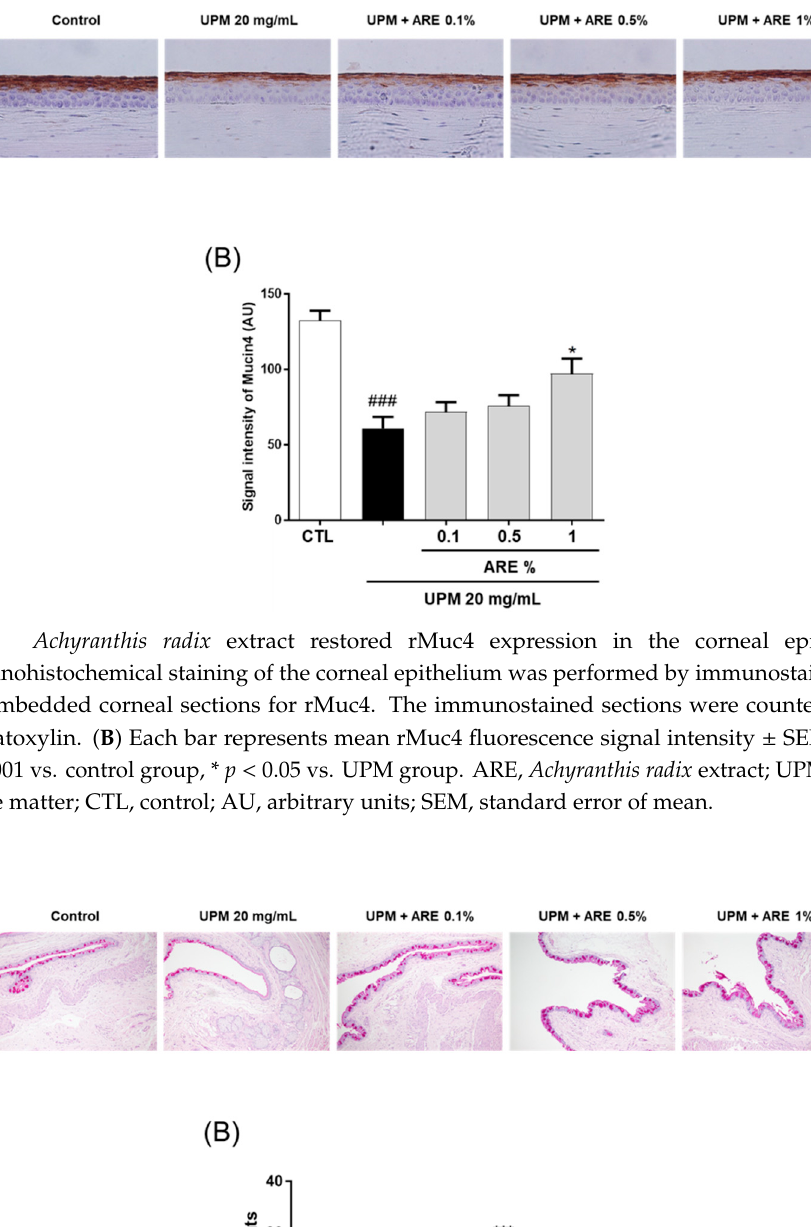
Figure 6. Achyranthis radix extract restored goblet cell population in the conjunctival epithelium. ( A ) Representative PAS-stained images of conjunctival sections. The violet colored cells are goblet cells. ( B ) Each bar represents the mean number of goblet cells ± SEM, n ≥ 3. ### p < 0.001 vs. control group, * p < 0.05, *** p < 0.001 vs. UPM group. ARE, Achyranthis radix extract; UPM, urban particulate matter; PAS, periodic acid-Schi ff ; CTL, control; SEM, standard error of